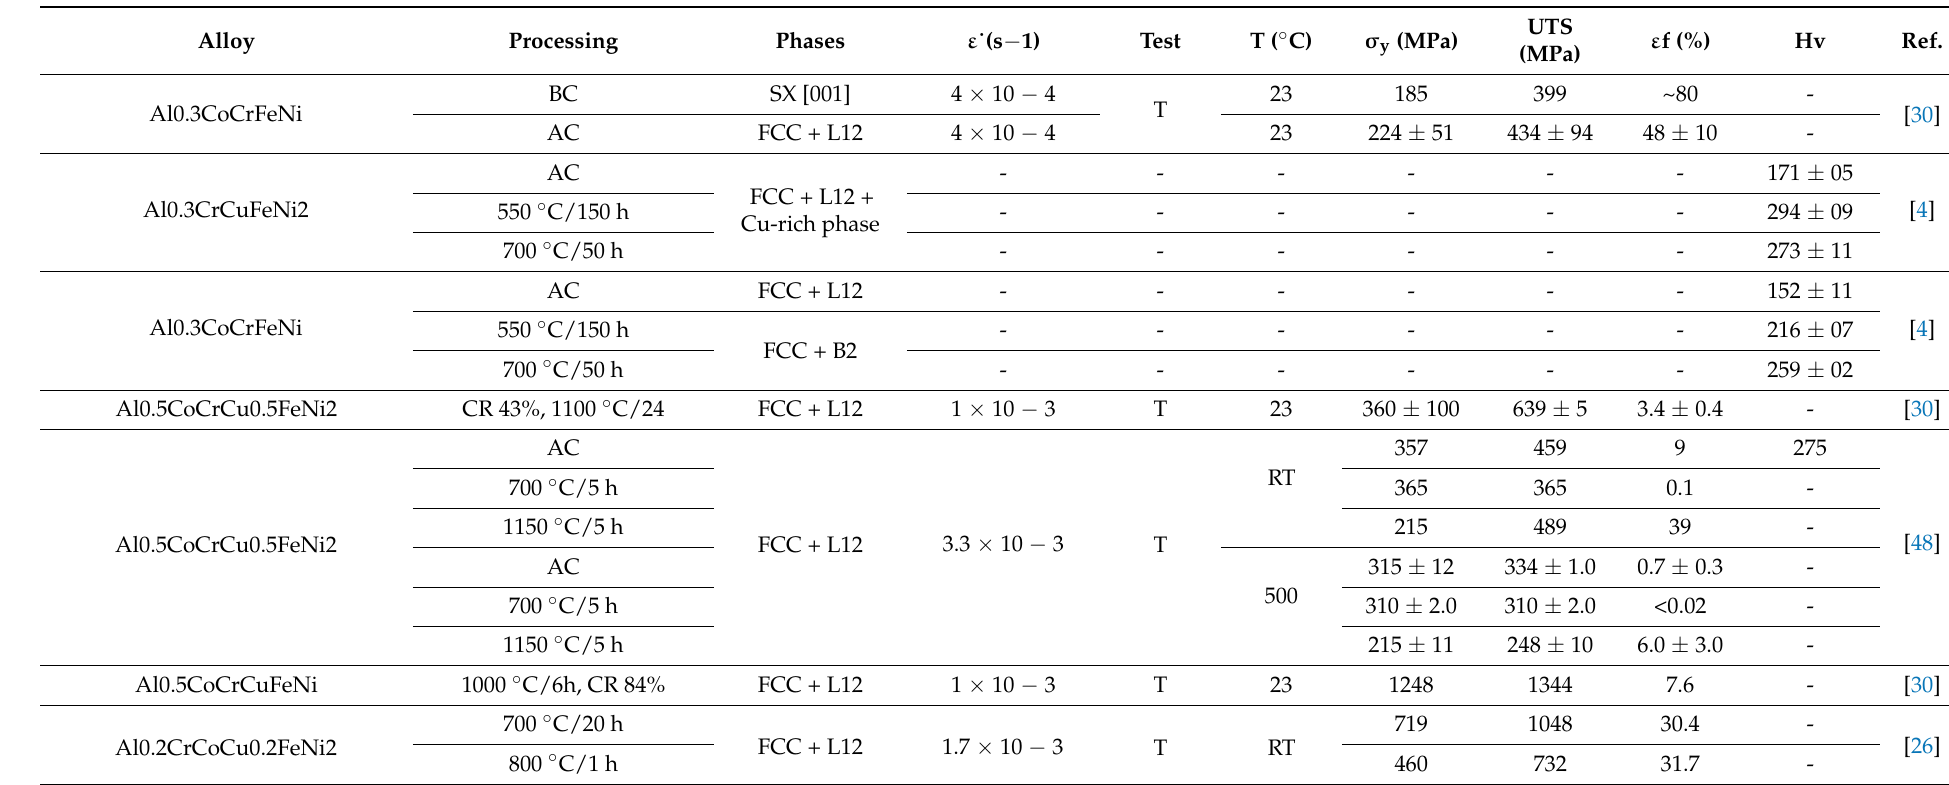
Table 3. Shows the processing route, phases and mechanical properties of HESAs extracted from the studies. BC-Bridgemann casting, AC-As-cast, CR-Cold-rolled, HIP-Hot-Isostatic pressing, SX-Single crystal, MA- and SPS-Mechanical alloying and spark plasma sintering, T-Tension, C-Compression, ´ ε -strain rate, T ( ◦ C) temperature, σ y -Yield strength, UTS-Ultimate tensile strength, ε f -elongation to fracture, Hv-Hardness in Vickers,